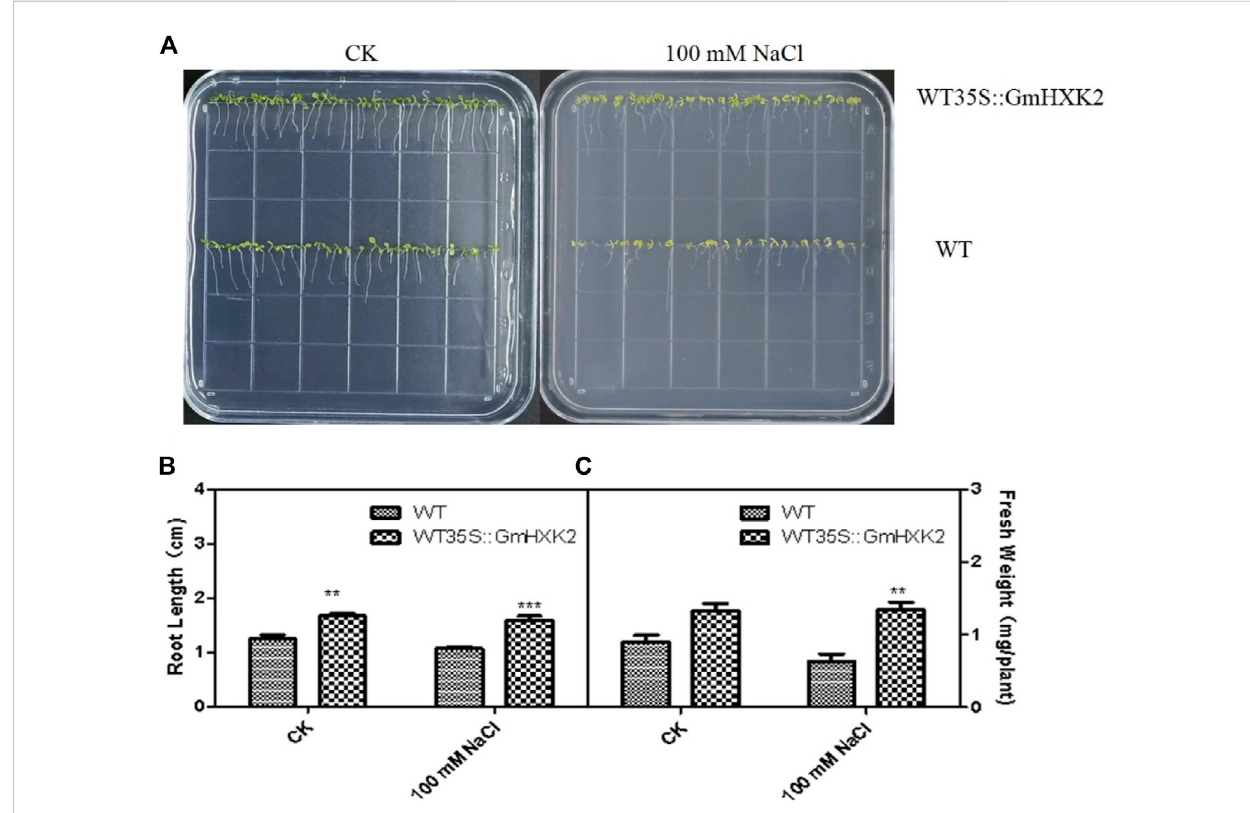
FIGURE 10 The phenotype (A) , root length (B) and fresh weight (C) of the WT and WT35S:: GmHXK2 transgenic Arabidopsis plants under salt stress at the germination stage. Seeds of WT and WT35S:: GmHXK2 were planted in 1/2 MS medium with or without100 mM NaCl for 7 days. Data are presented as mean ± SE (n = 5, biological replicates). Single, double and three asterisks denote signi fi cant differences at p < 0.05, p < 0.01 and p < 0.001, respectively; Student ’ s t-test.